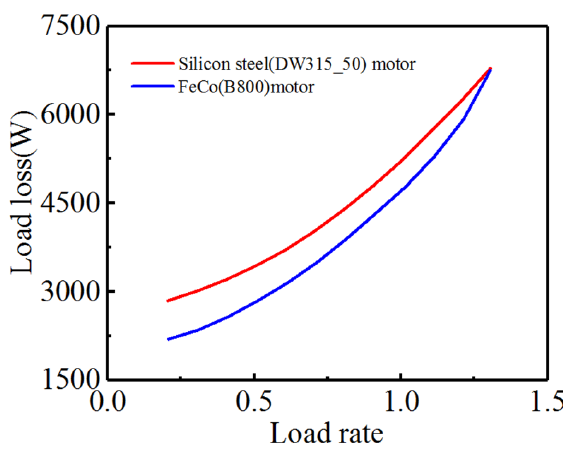
Figure 8. Load loss comparison curve.